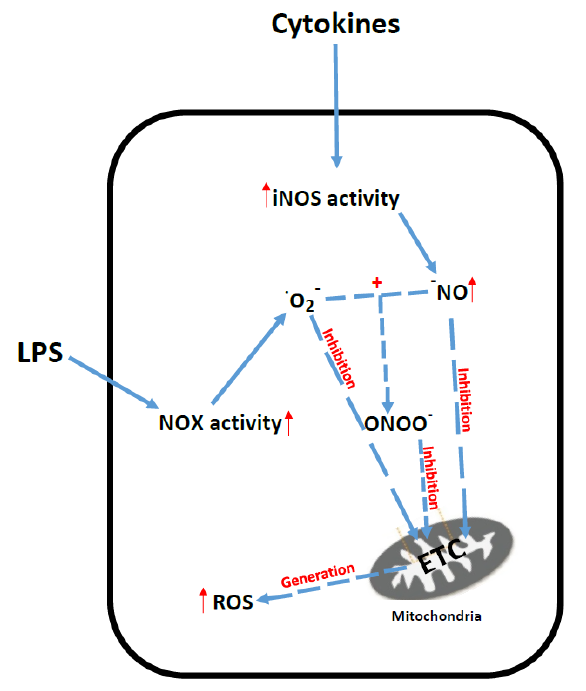
Figure 7. Putative mechanisms of oxidative stress and mitochondrial dysfunction in sepsis. iNos: Inducible nitric oxide synthase; NO x : NADPH oxidase; O 2− : Superoxide; NO: Nitric oxide; ROS: Reactive oxygen species; ETC: Mitochondrial electron transport chain; ONOO − : Peroxynitrite; LPS: